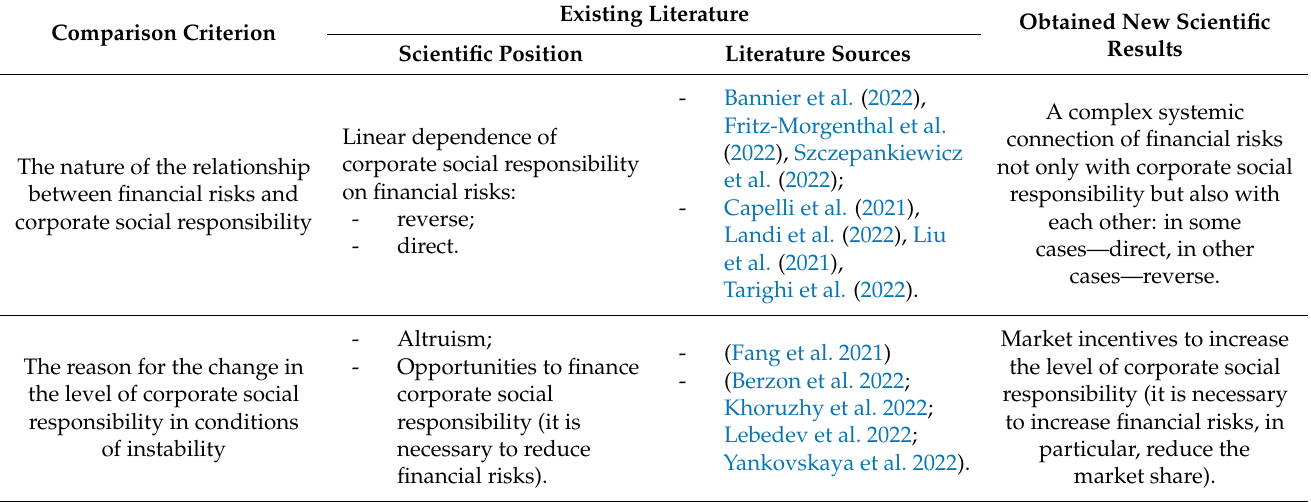
Table 7. Comparative analysis of the obtained results with the existing